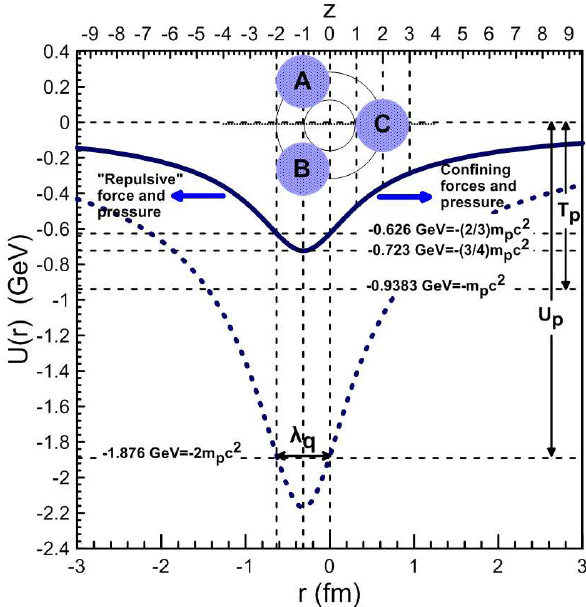
Figure 3: Force and pressure in the proton. Plot of eqs (8) and (9) showing the radial force exerted on quark C, by quarks A and B, as a function of the distance from the center of the proton. At r = 0 the total force exerted on the three particles in the x direction vanishes and the rotational radius equals the quark Compton wavelength ¯ λ